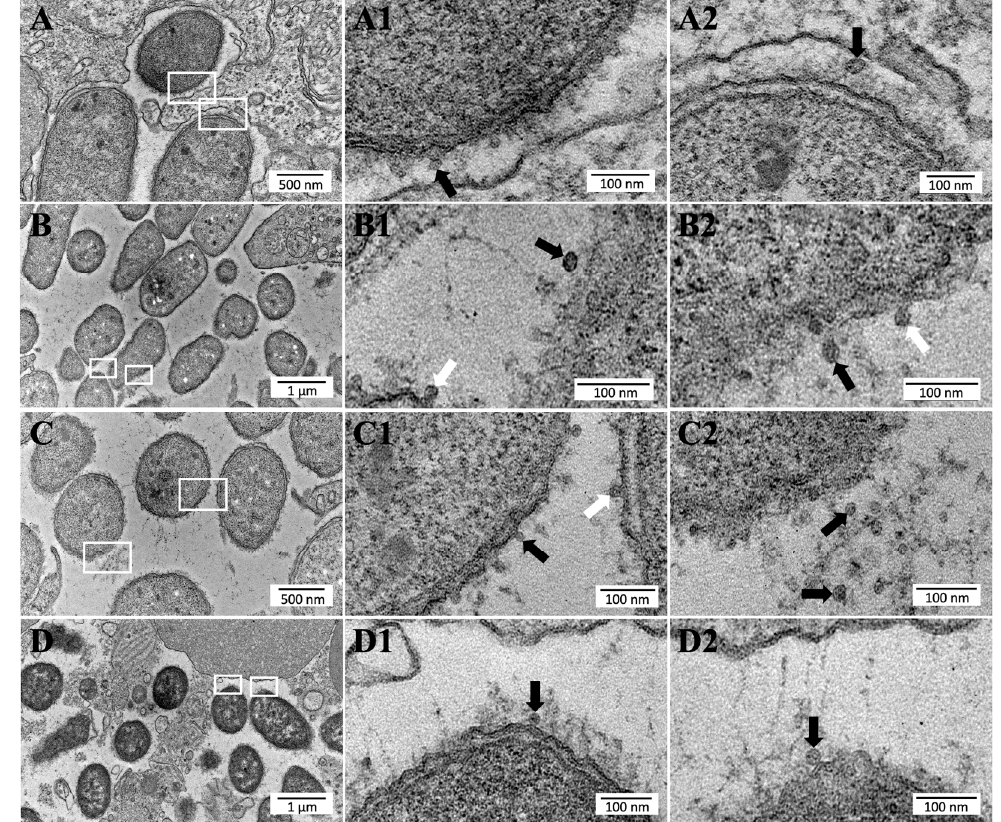
Figure 4. Phdp releases OMVs during in vivo infection. Representative TEM images of ultrathin sections of spleens from sea bass experimentally infected with the Phdp field isolate GRDL19-1, showing bacterial cells shedding high numbers of OMVs (A–D). The middle and right pictures (labeled with 1 and 2) show higher magnifications of the white squared areas. Black arrows indicate fully formed OMVs and white arrows indicate vesicles budding out from the outer membrane of bacterial cells.